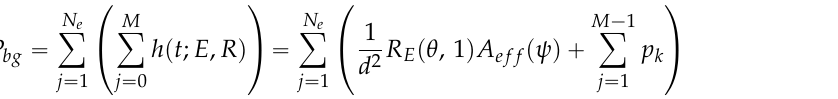
Figure 6. Path loss for the sectored angle-diversity receiver (SDR), the conventional angle-diversity receiver (CDR) and the self-orienting receiver (SOR) as a function of the emitter-receiver distance along the diagonal from northwest (negative values) to southeast (positive values).